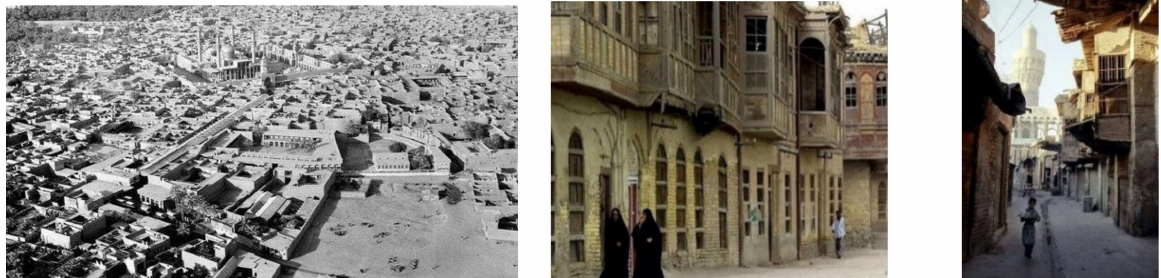
Figure 3. Various shots show details and components of the urban fabric of Al-Kadhimiya district, old Baghdad [36,37].